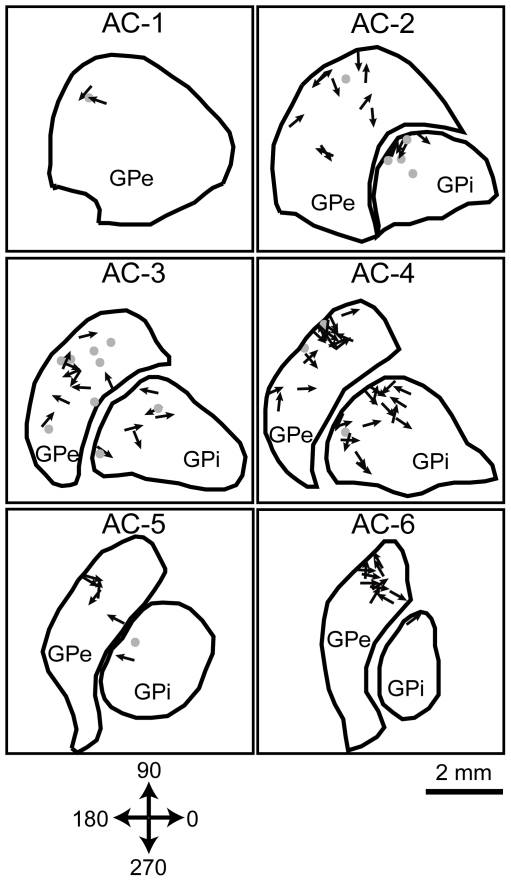
Histological reconstruction of the recording sites.The recording sites, indicated by arrows (movement responding neurons) and circles (non-responding neurons) are superimposed on reconstructed coronal brain slices (monkey N). The direction of each arrow indicates the phase of the peak response relative to the beginning of the movement cycle.